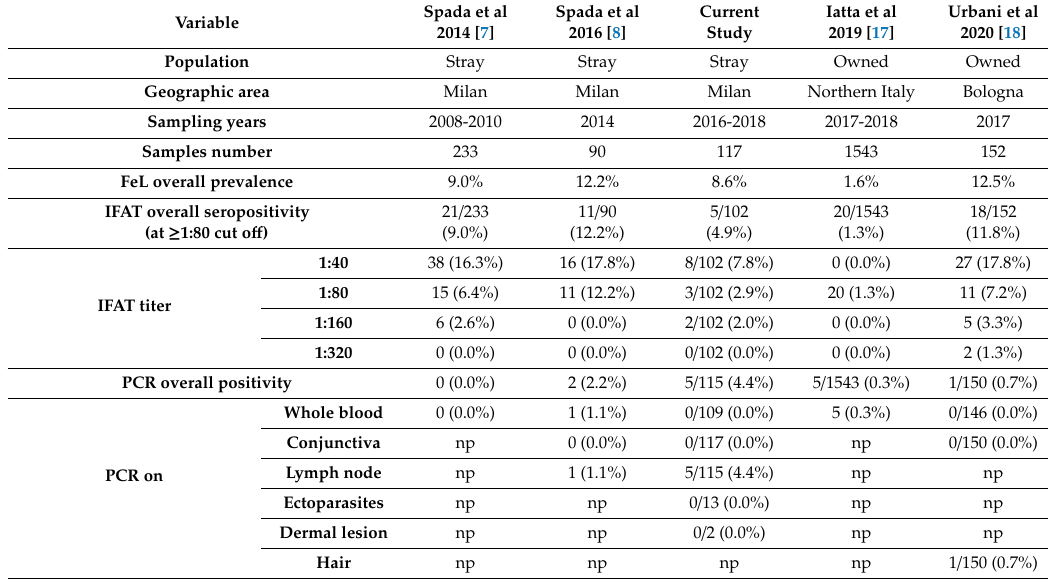
Table 3. Comparison of results of epidemiological studies for L. infantum infection of the current study with other recent studies performed in cats in northern Italy. Variable Stray Stray Stray Owned Owned Geographic area Milan Milan Milan Northern